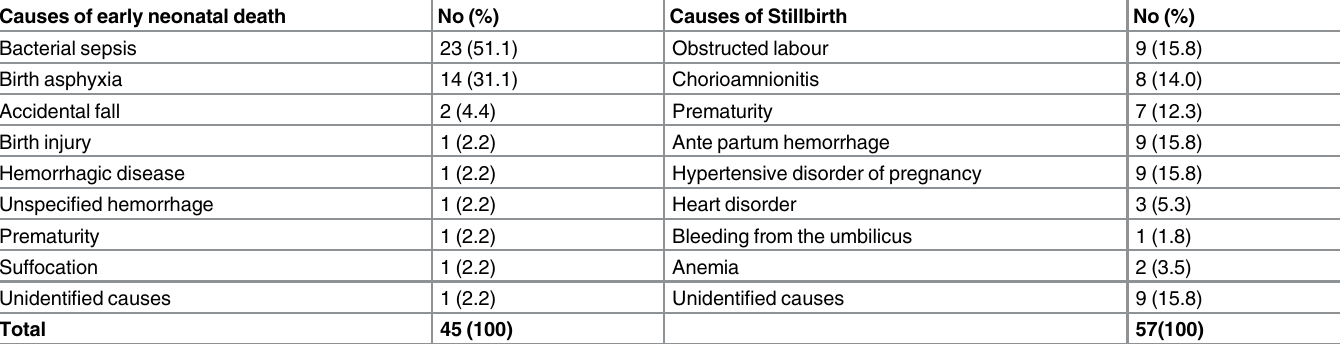
Table 4. Probable causes of stillbirths and early neonatal deaths from a verbal autopsy data in west Gojam zone, Ethiopia Feb 2012(n = 102). Causes of early neonatal